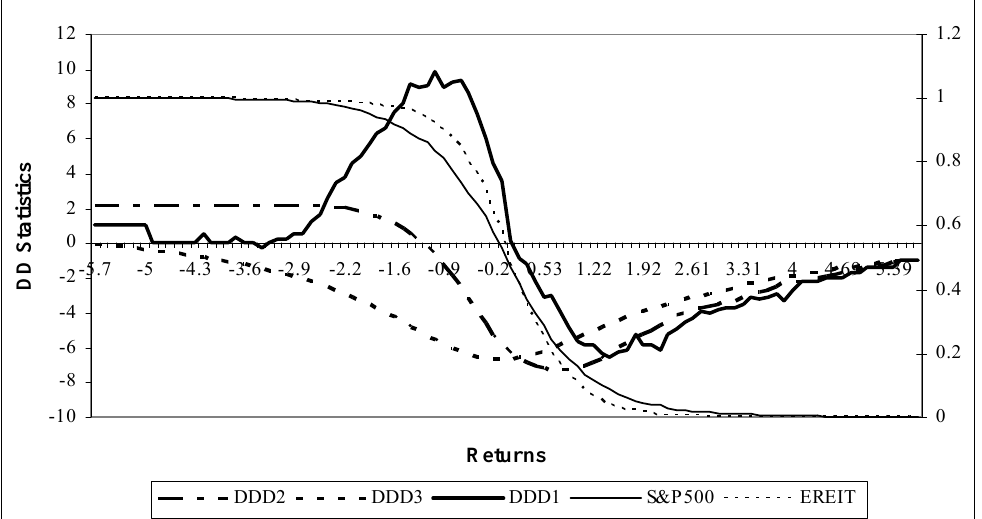
Figure 3: Descending CDF and DD Statistics Between Equity REITs and the S&P 500 for